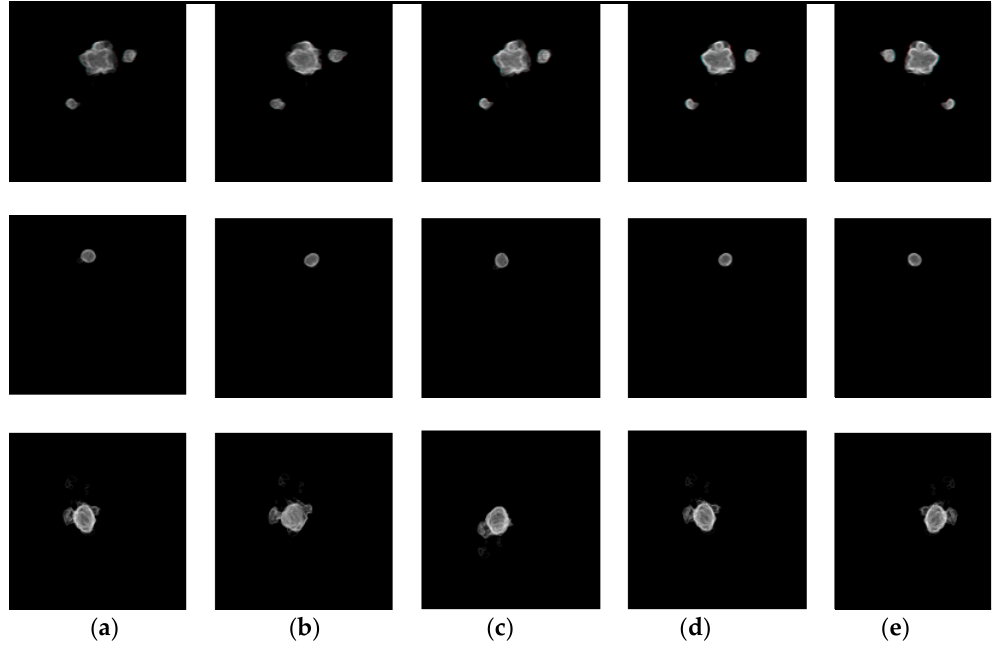
Figure 11. 3D visualization results of three different cases. Each row shows a case of tumor segmentation results in sequential 15 slices and 3D visualization. From left to right: ( a ) Front view, ( b ) Top view, ( c ) Left view, ( d ) Bottom view, ( e ) Right